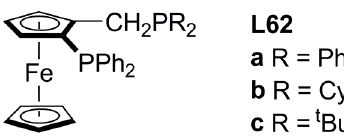
Figure 22. JOSIPHOS-related diphosphines